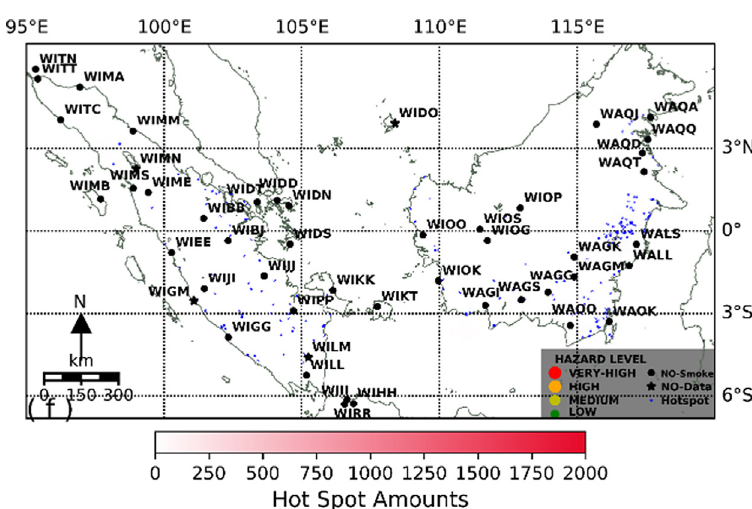
Fig. 4 f. The same as Fig. 4 a, for Month December